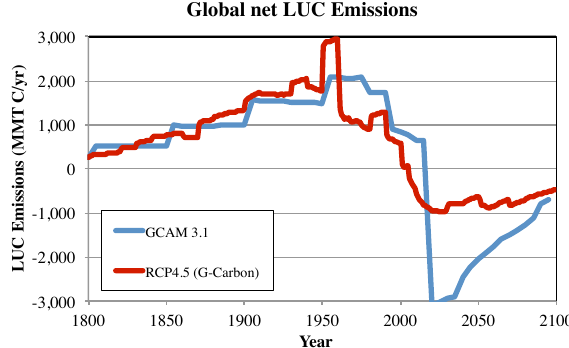
Fig. 3. Global LUC emissions from the G-Carbon model and from the latest GCAM release version